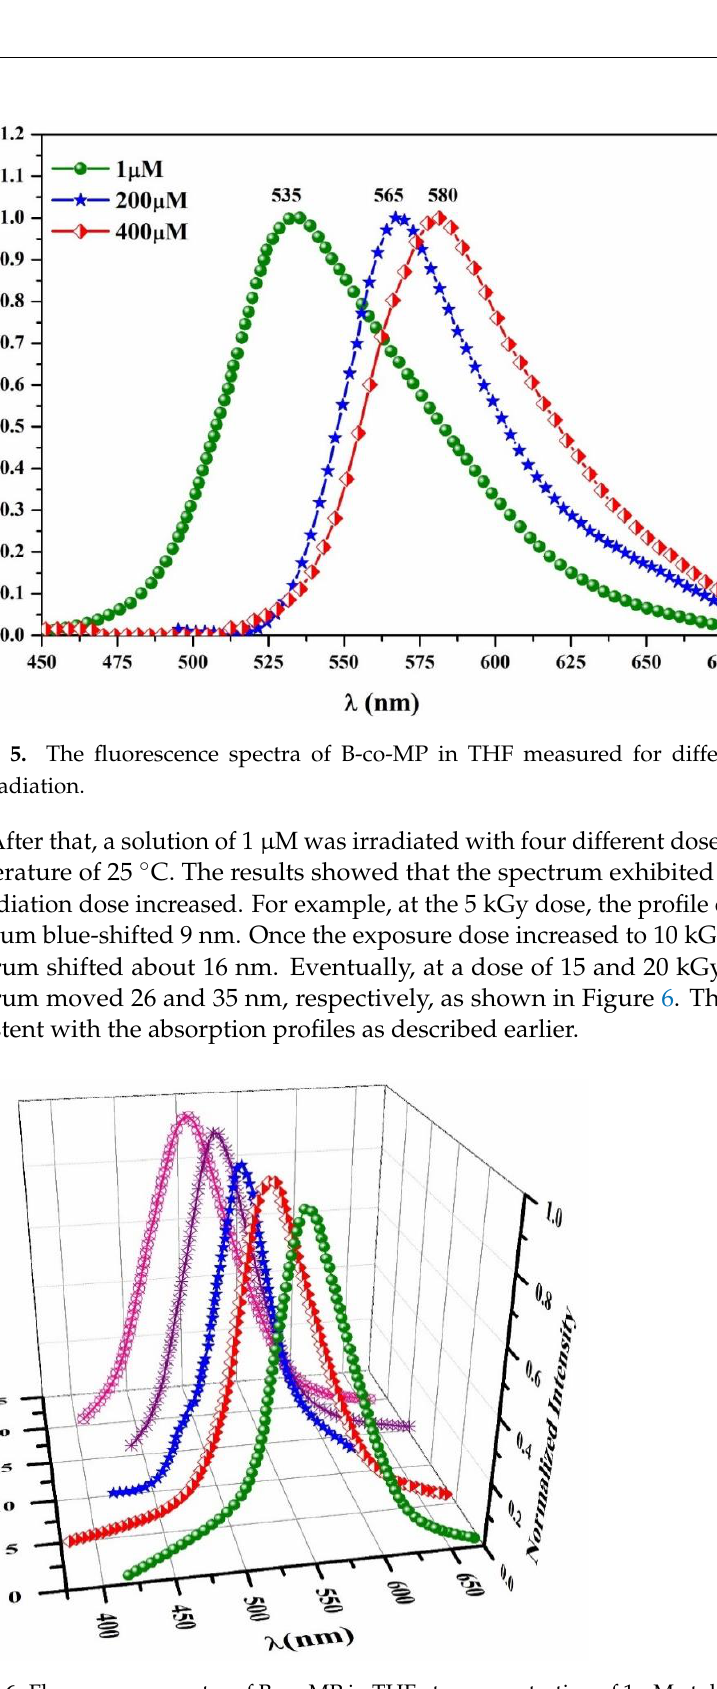
Figure 6. Fluorescence spectra of B-co-MP in THF at a concentration of 1 µM at different γ -irradiation doses.